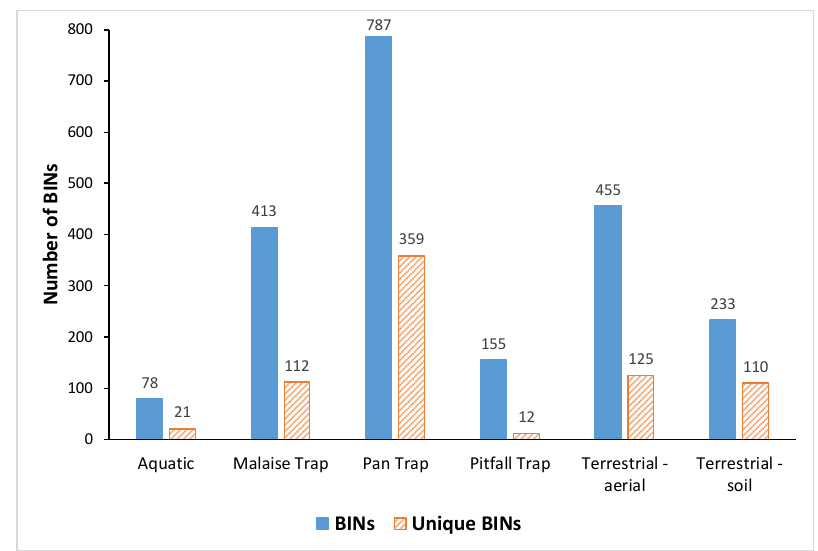
Figure 4. Observed species richness (BINs) and number of unique BINs sampled by the main categories of collecting protocols.